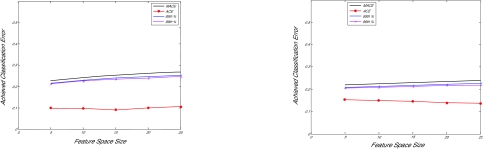
PACE analysis using a SVM-based classifier using the Fisher scoring criterion, with a 0.6 MAC threshold. Left Panel: performance without peak selection. Right panel: performance with peak selection.